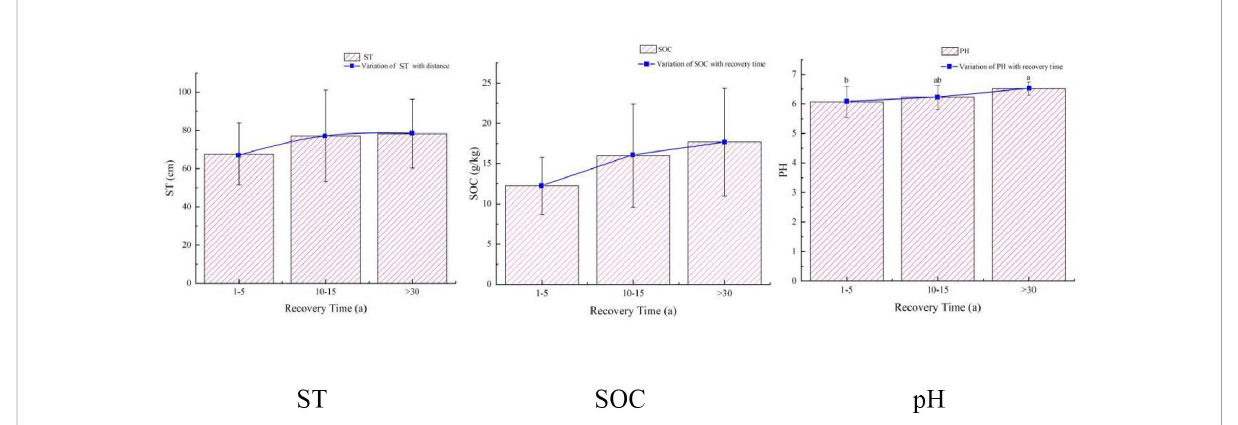
quality was mainly affected by recovery time (Figure 6). In Figure 6, various indices of soil SOC, pH, EC, and TP indices were greatly affected by the recovery time, whereas the TN,